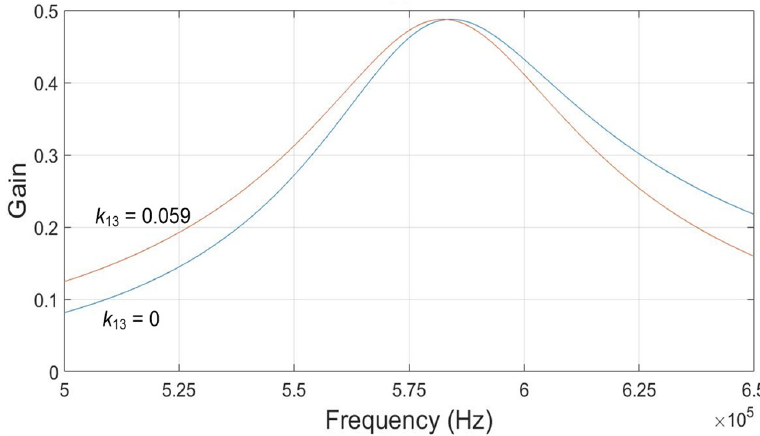
Figure 10. Frequency response of the system with k 13 = 0 and k 13 = 0.059. Table 2. k 12 , M 12 and k 23 in three operating zones.